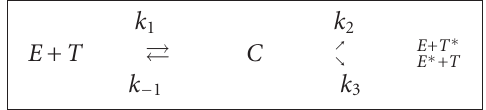
Figure 2.1. Kinetic scheme describing interactions between ECs and TCs (see